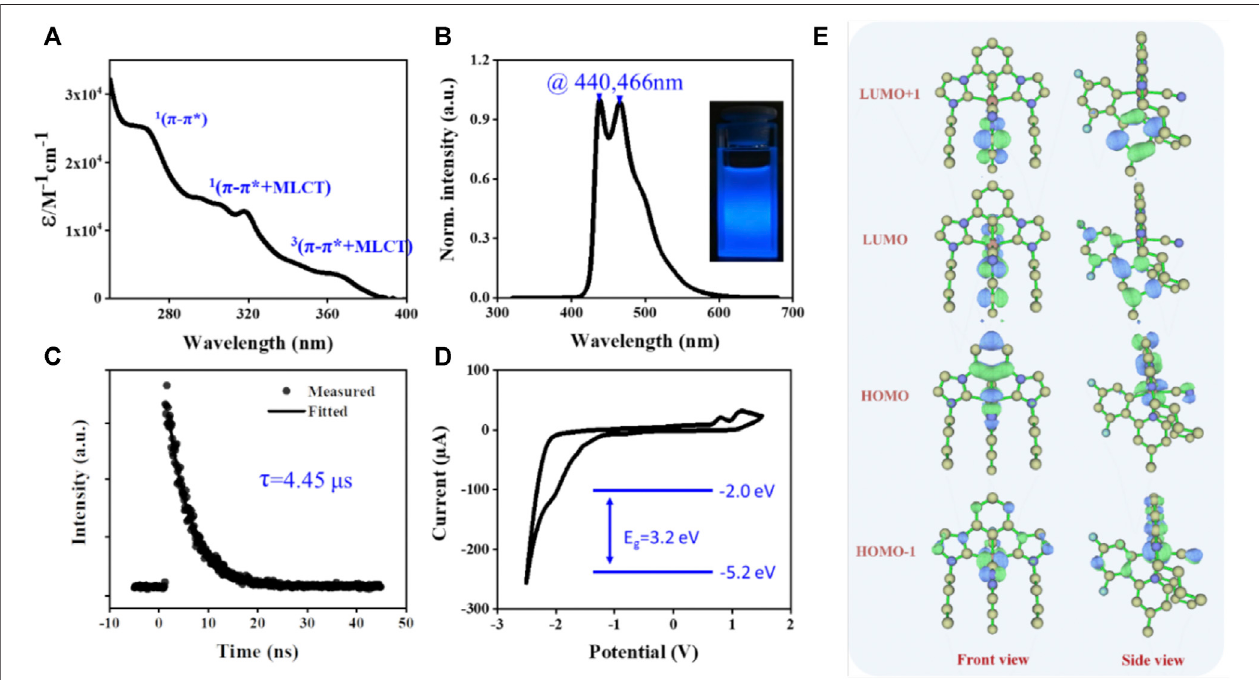
FIGURE2| Thephotophysicalpropertiesofthe [3+2+1] iridium (III) complex Ir-dfpMepy-CN . (A) the absorption spectra and (B) normalizedPL spectra ofdiluted inCH 2 Cl 2 solution. (C) Lifetimedecaycurvesat440 nmand (D) cyclicvoltammograms(CV)inDCMwith n Bu 4 NPF 6 (0.1 M)assupportingelectrolytes. (E) Thecomputed frontier molecular orbitals energy surfaces at the ground state (S 0 ) optimized geometry.